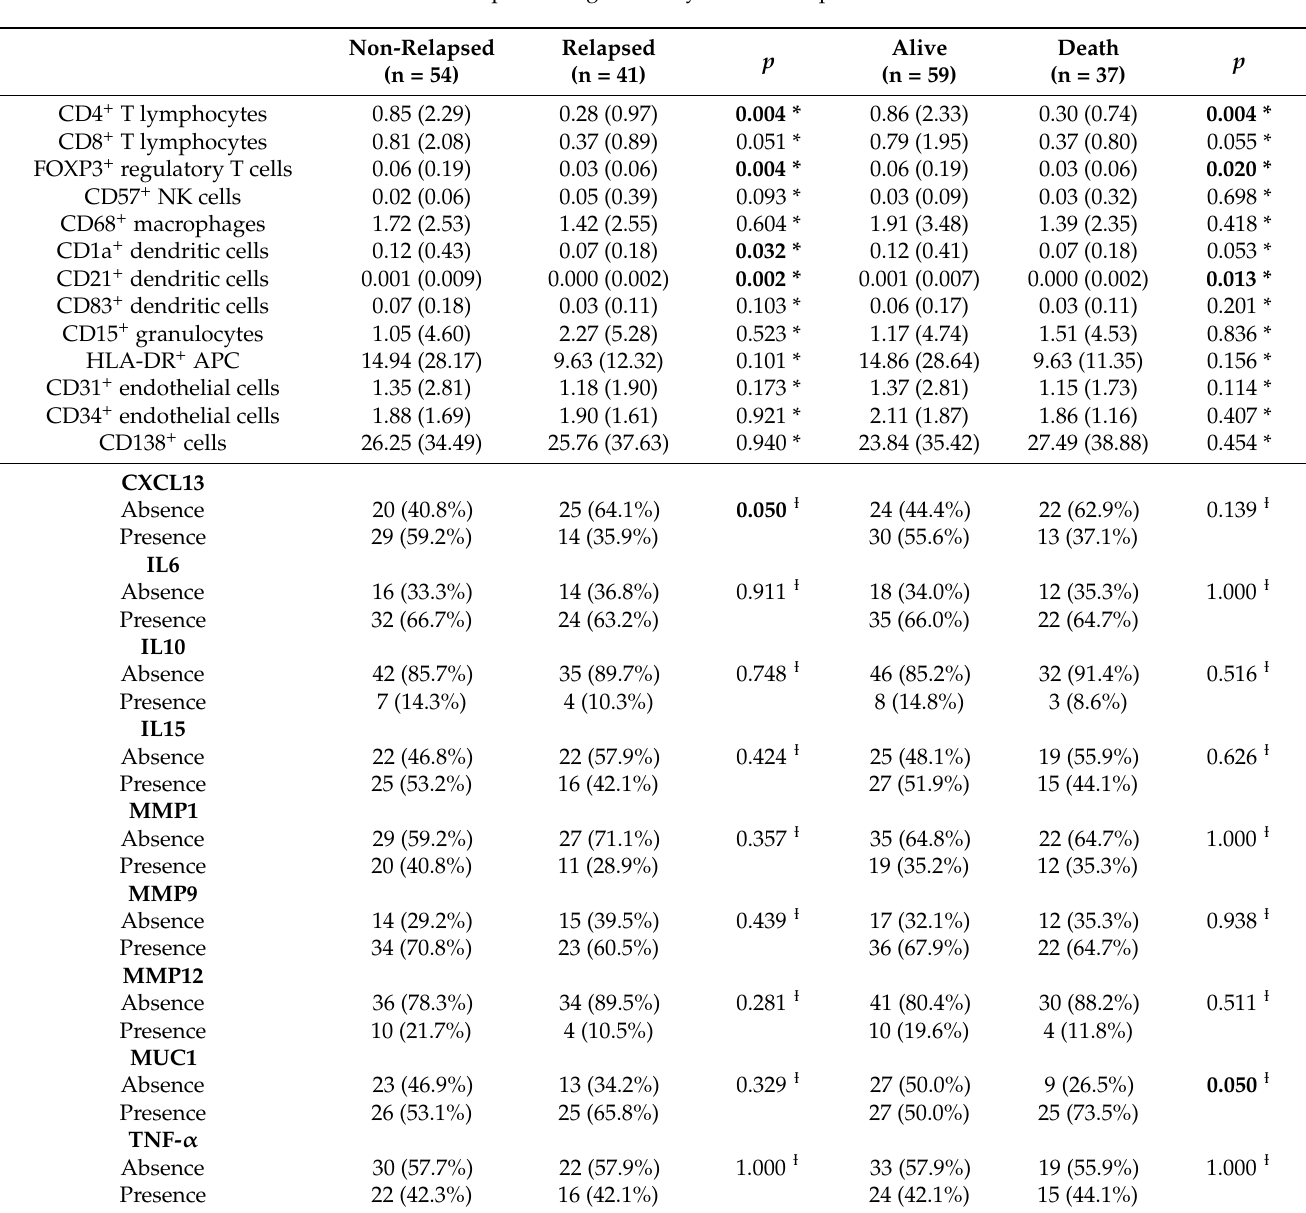
Table 2. Cellular and genetic immune markers in the residual tumor microenvironment according to survival and relapse during the five-year follow-up.